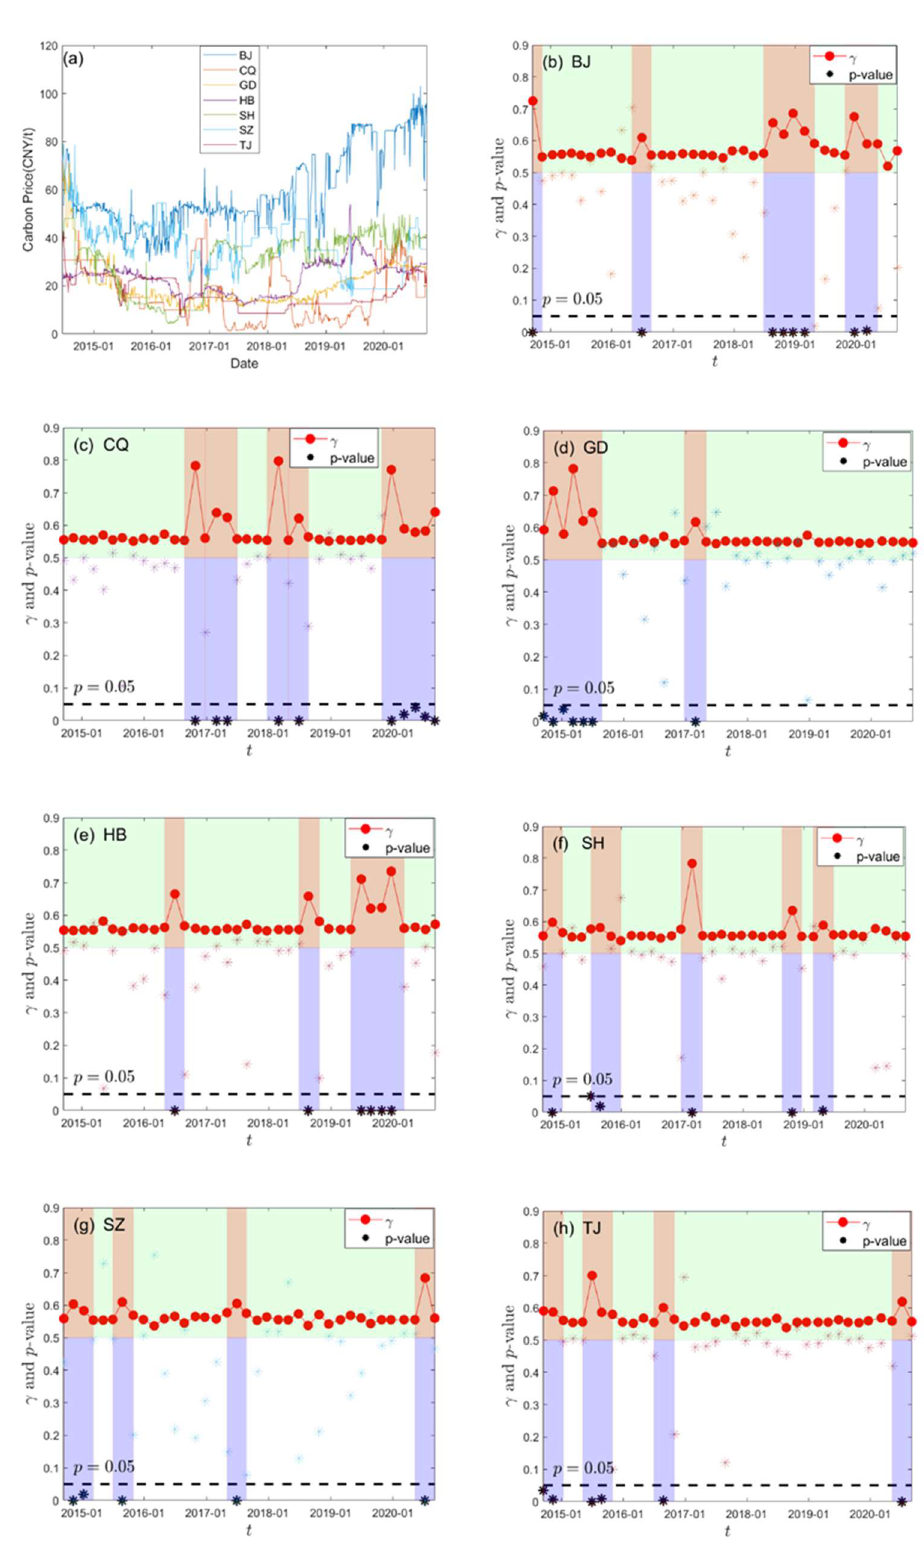
Figure 5. Identification results of breakpoints of carbon price data in China’s carbon market: ( a ) evolution of sample data in seven pilot markets; ( b – h ) identification results based on PDRN of seven pilot markets.